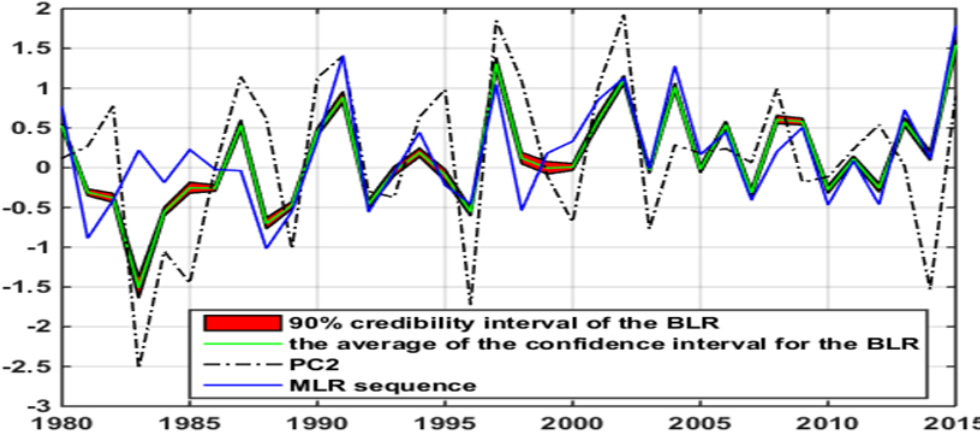
Figure 10. Comparison among the BLR-predicted results, the multiple linear regression (MLR) sequence and PC2 (the red area represents the 90% confidence interval of the BLR model, and the green thick solid line is the average of the confidence interval for BLR). Table 15. Skill scores (in terms of the multiple correlation coefficient (MCC) and root mean square error (RMSE)) for the PC1 forecast by different models (bold font indicates the best performance).